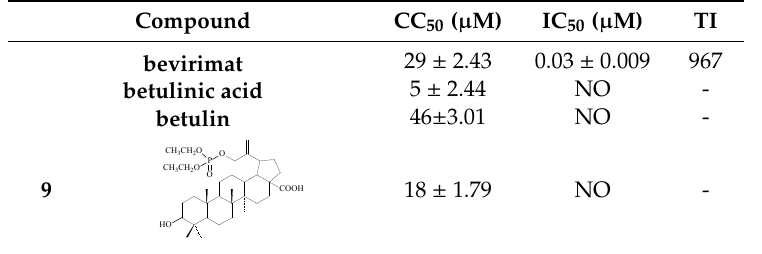
Table 2. Anti-HIV-1 replication activities in human immunodeficiency virus (HIV)-infected CEM-T4 cell line.